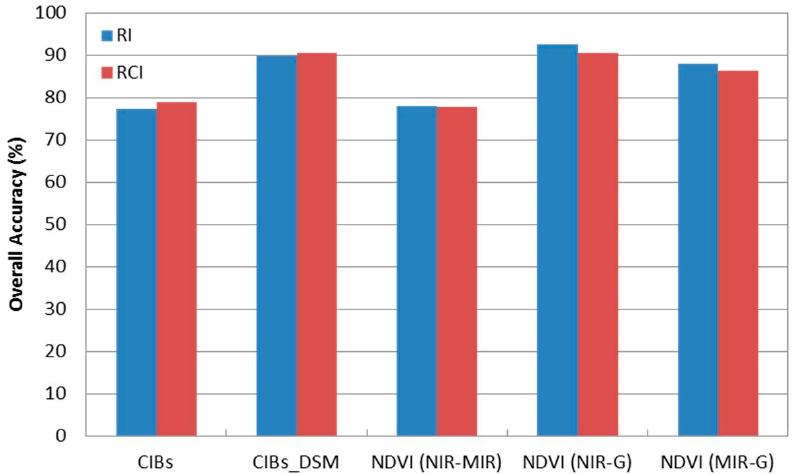
Figure 9. Overall accuracy from the two classification techniques.